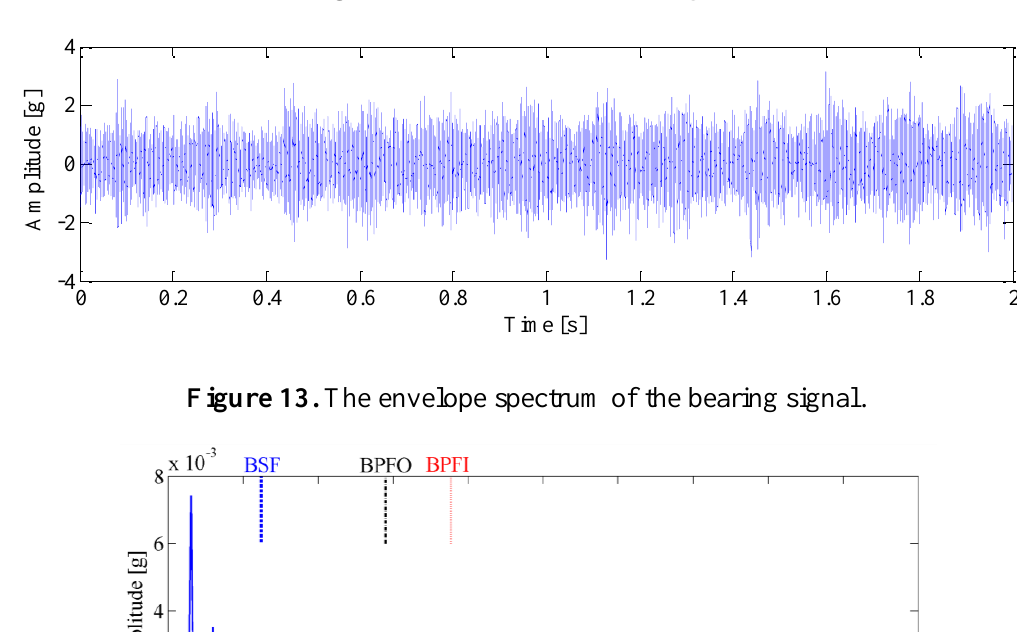
Figure 12. The raw vibration signal.